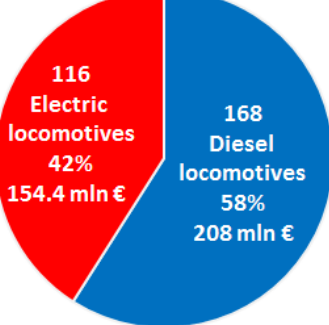
Fig. 7. Investments into diesel and electric locomotives planned for 2023 in Poland (for the group of surveyed carriers performing 80% of national transport operations)